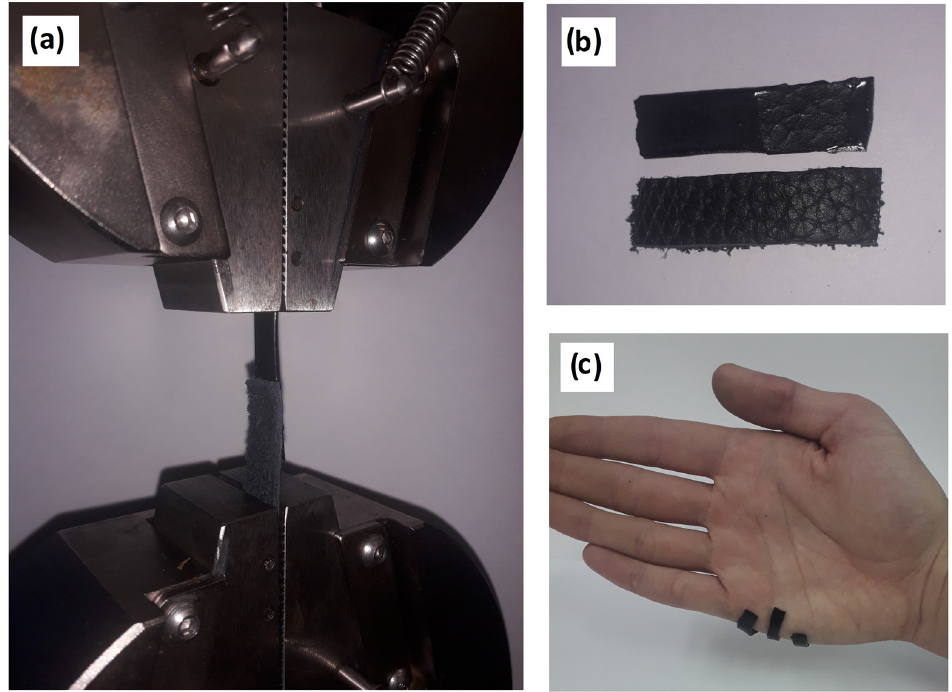
Figure 2. Adhesion experiments: ( a ) installation of a sample for shear testing, ( b ) the mixed nature of adhesive failure, and ( c ) visual demonstration of hydrogel adhesion to human skin.